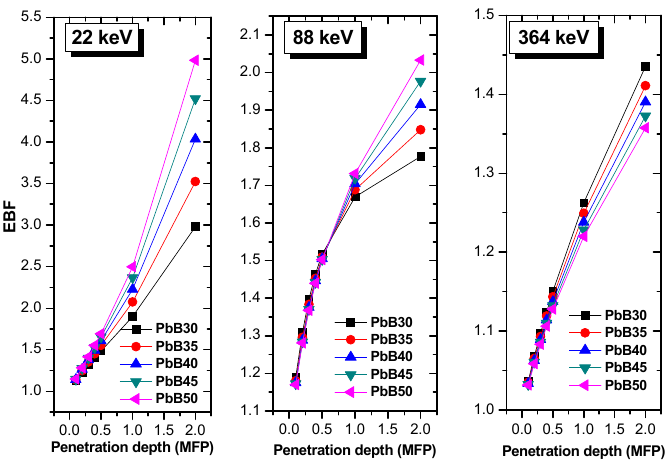
Figure 7. Variation of EBF with penetration depth at selected energies of 22, 88 and 364 keV. In order to compare the shielding power of the investigated glass system with those of conventional shields (ordinary concrete (OC), high density steel magnetite concrete (StMag) and two commercial glass shields containing lead known with the tradenames RS-360 and RS-253-G18), the mean free path (MFP) was used. As a shielding parameter, high MFP indicates that photon moves a large distance before interaction, and hence at- tenuation is reduced. Figures 8 and 9 show the comparison in the value of MFP of the glass systems and those of other materials (OC, StMag), RS-360 and RS-253-G18) at all the considered photon energies. The figures reveal that MFP increases with energy for all me- dia due to low interaction cross section of photons at higher energies. However, at equal energy, the photon shielding capacity of the PbB-glasses was superior to those of the com- pared materials. This is a strong empirical indication that the glasses included in the pre- sent study possess better photon protection capacity compared to these conventional shields.